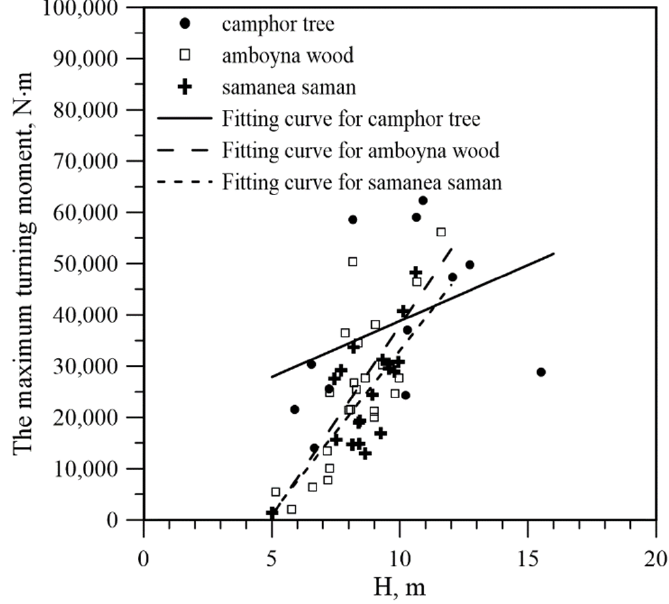
Table 5. Regression equations for the relationship between TM max and tree height (H) in near- saturated soil conditions.